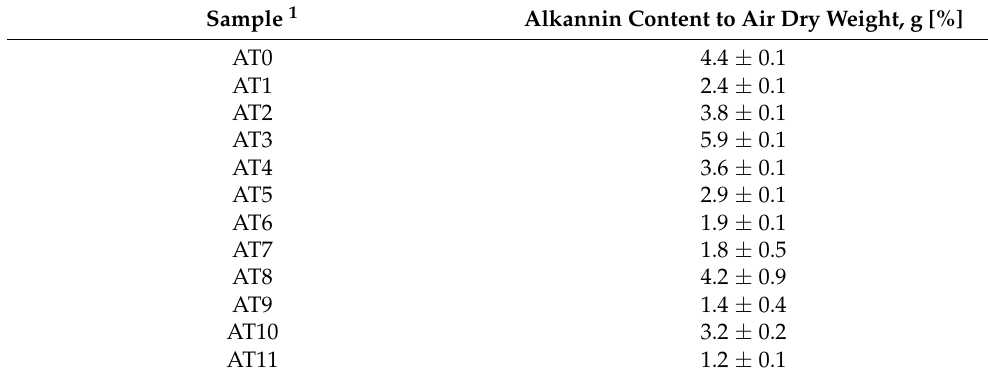
Table 2. Spectrophotometric determination on the alkannin content in the studied samples of Alcanna tinctoria roots.